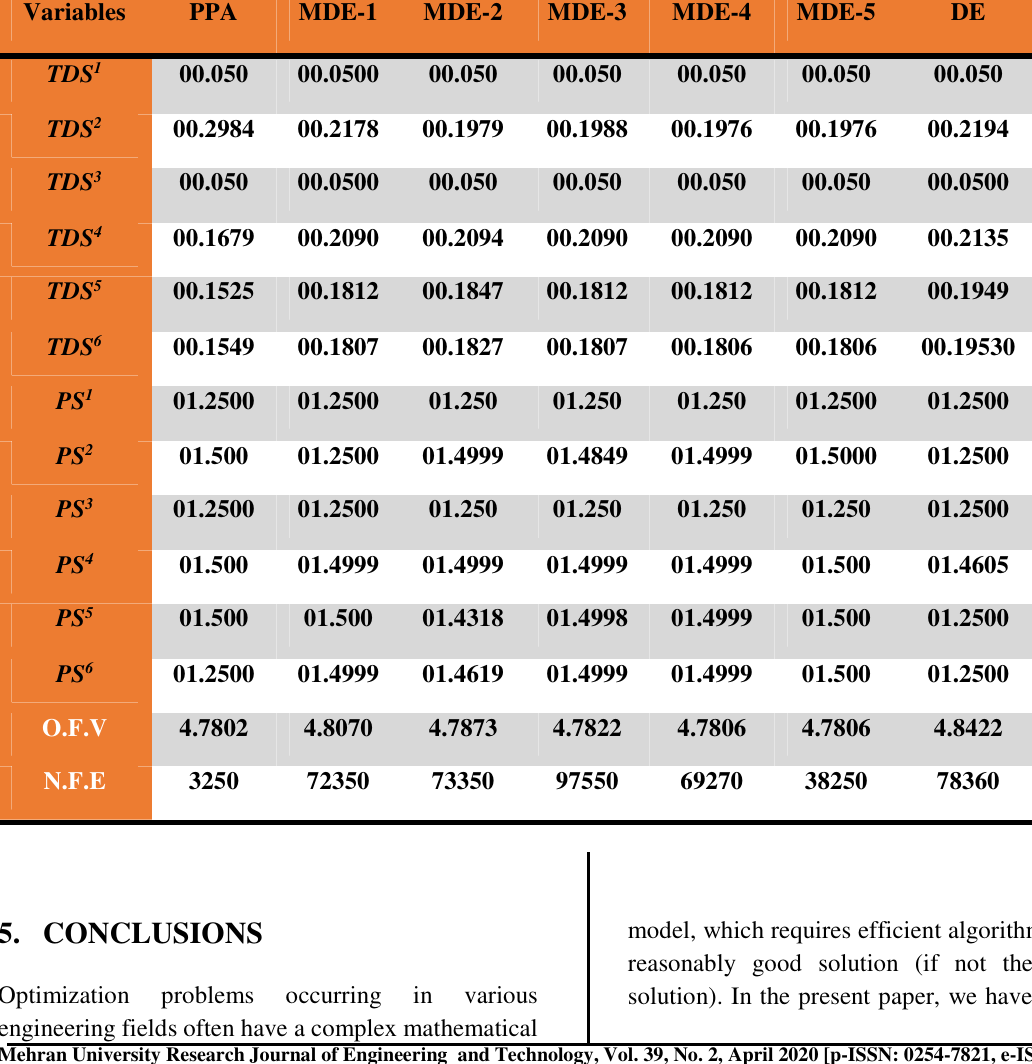
TABLE 1: BEST DECISION VARIABLES, OBJECTIVE VALUES, AND NUMBER OF FUNCTION EVALUATION OF PROBLEM-1 3-BUS MODEL BY PPA